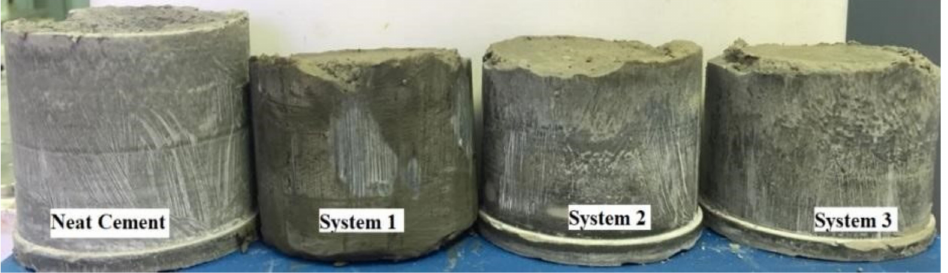
Figure 16. The morphology of standard slurry (STD) and the cement contaminated with systems 1, 2 and 3 after the ultrasonic cement analyzer (UCA)